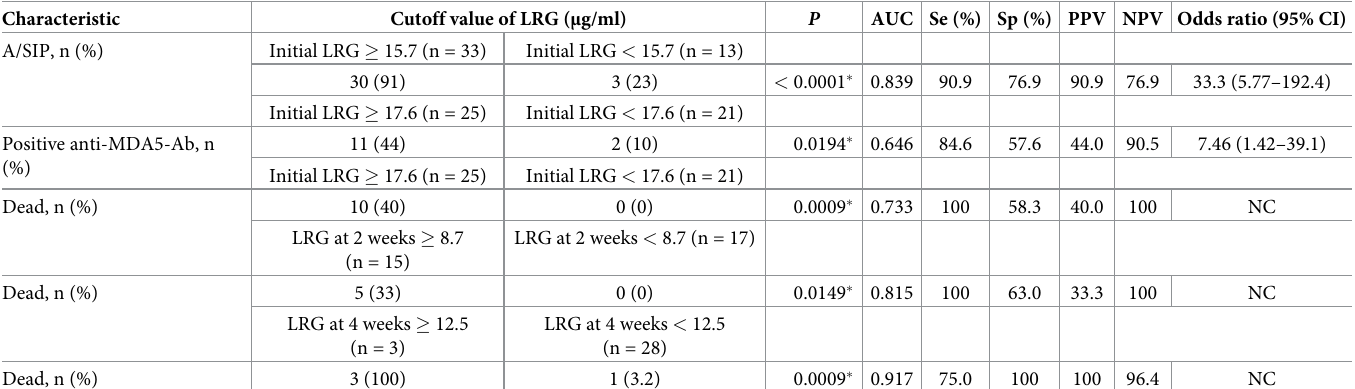
Table 4. Ratios of A/SIP and positive anti-MDA5-Ab by the higher or lower of the cut-off values of initial serum LRG level, and patients dead due to IP by the higher or lower of the cut-off values of initial, 2-week, and 4-week serum LRG levels. Characteristic